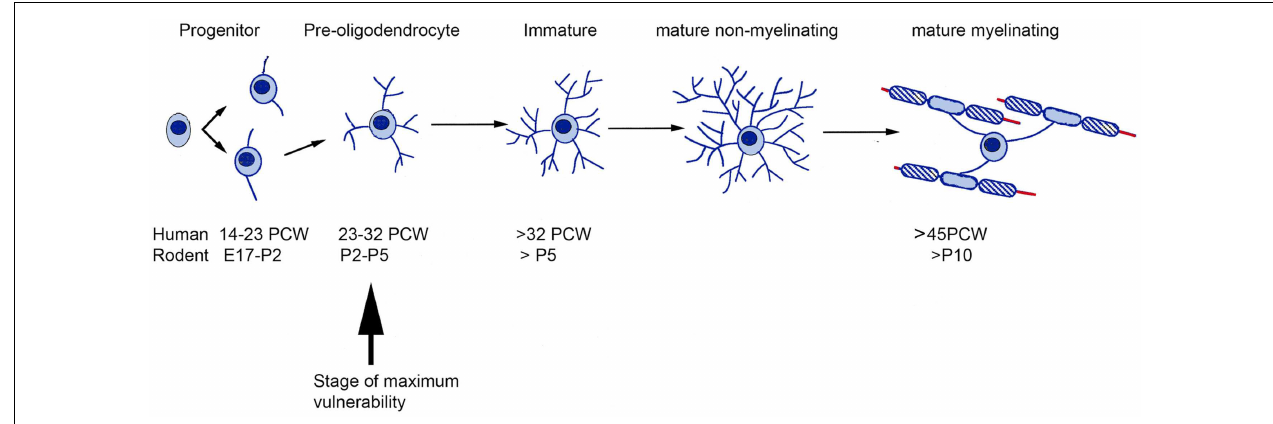
FIGURE 2 |A comparative timetable of oligodendrocyte development between rodent and human .The time of greatest vulnerability to hypoxia/ischemia (arrow) is at the pre-oligodendrocyte stage of development. Based on the information from Ref. (34–36). E, Embryonic day; PCW, post-conceptional weeks.